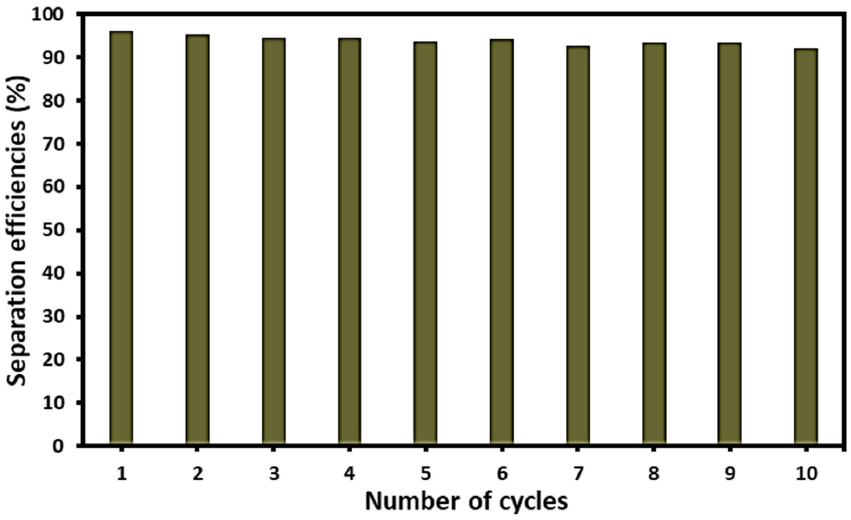
Figure 7. Separation efficiency and reusability of the C18s-Ag-DA-Cell-F.